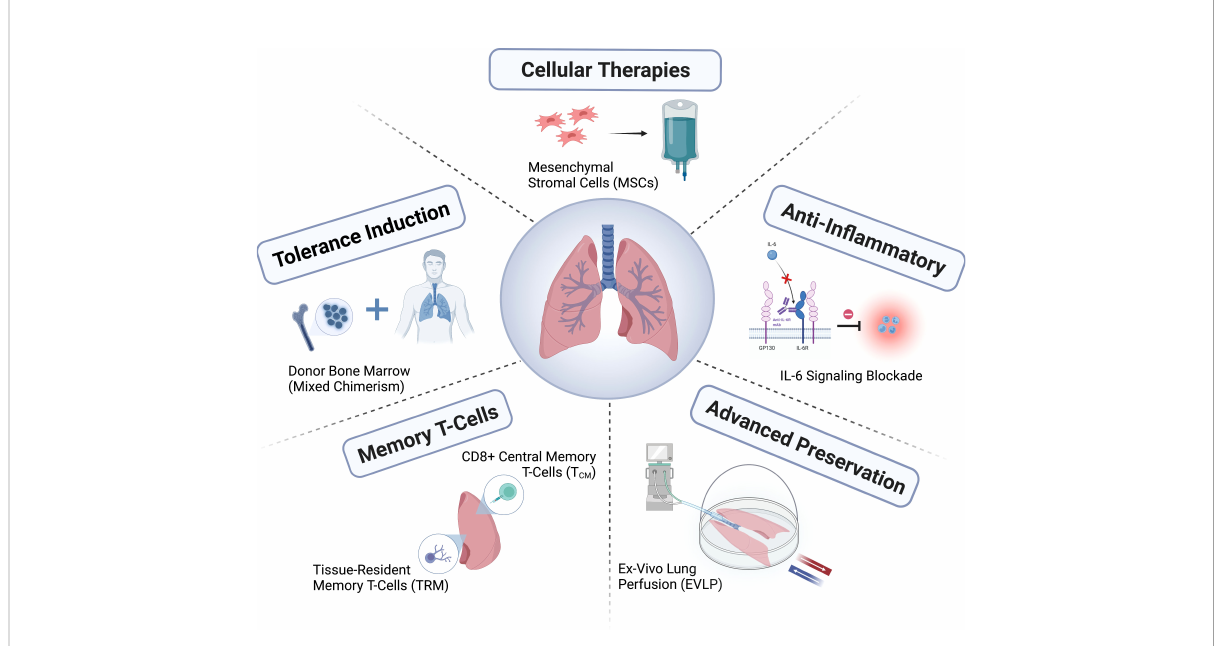
FIGURE 1 Novel approaches to achieve long-term lung transplant